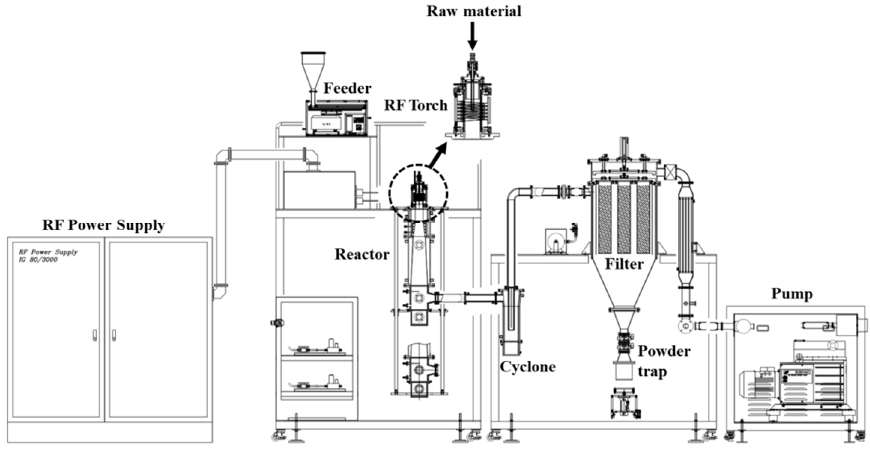
Figure 1. Schematic of the RF thermal plasma system.